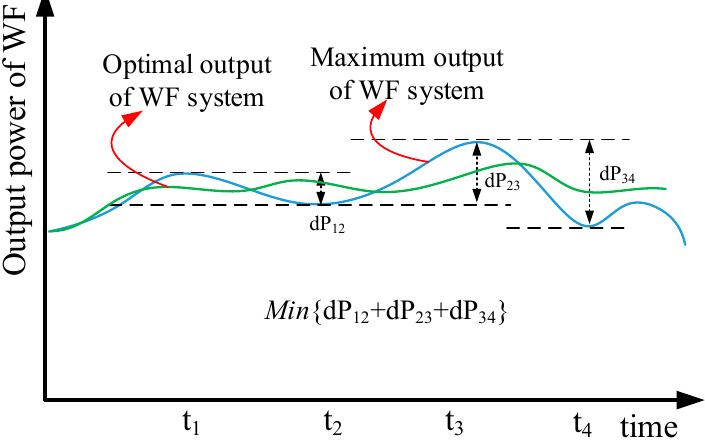
Figure 2. Problem in the operation of the WF system (each time interval is set to 5 minutes).